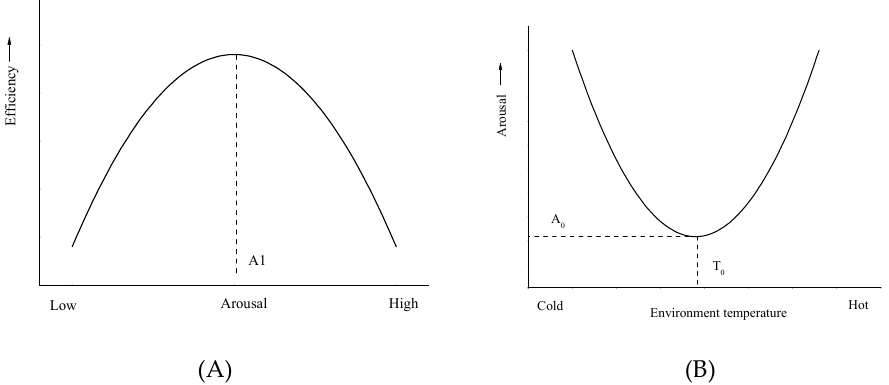
Figure 5. The relationships between: ( A ) Efficiency and arousal; ( B ) arousal and environment temperature.